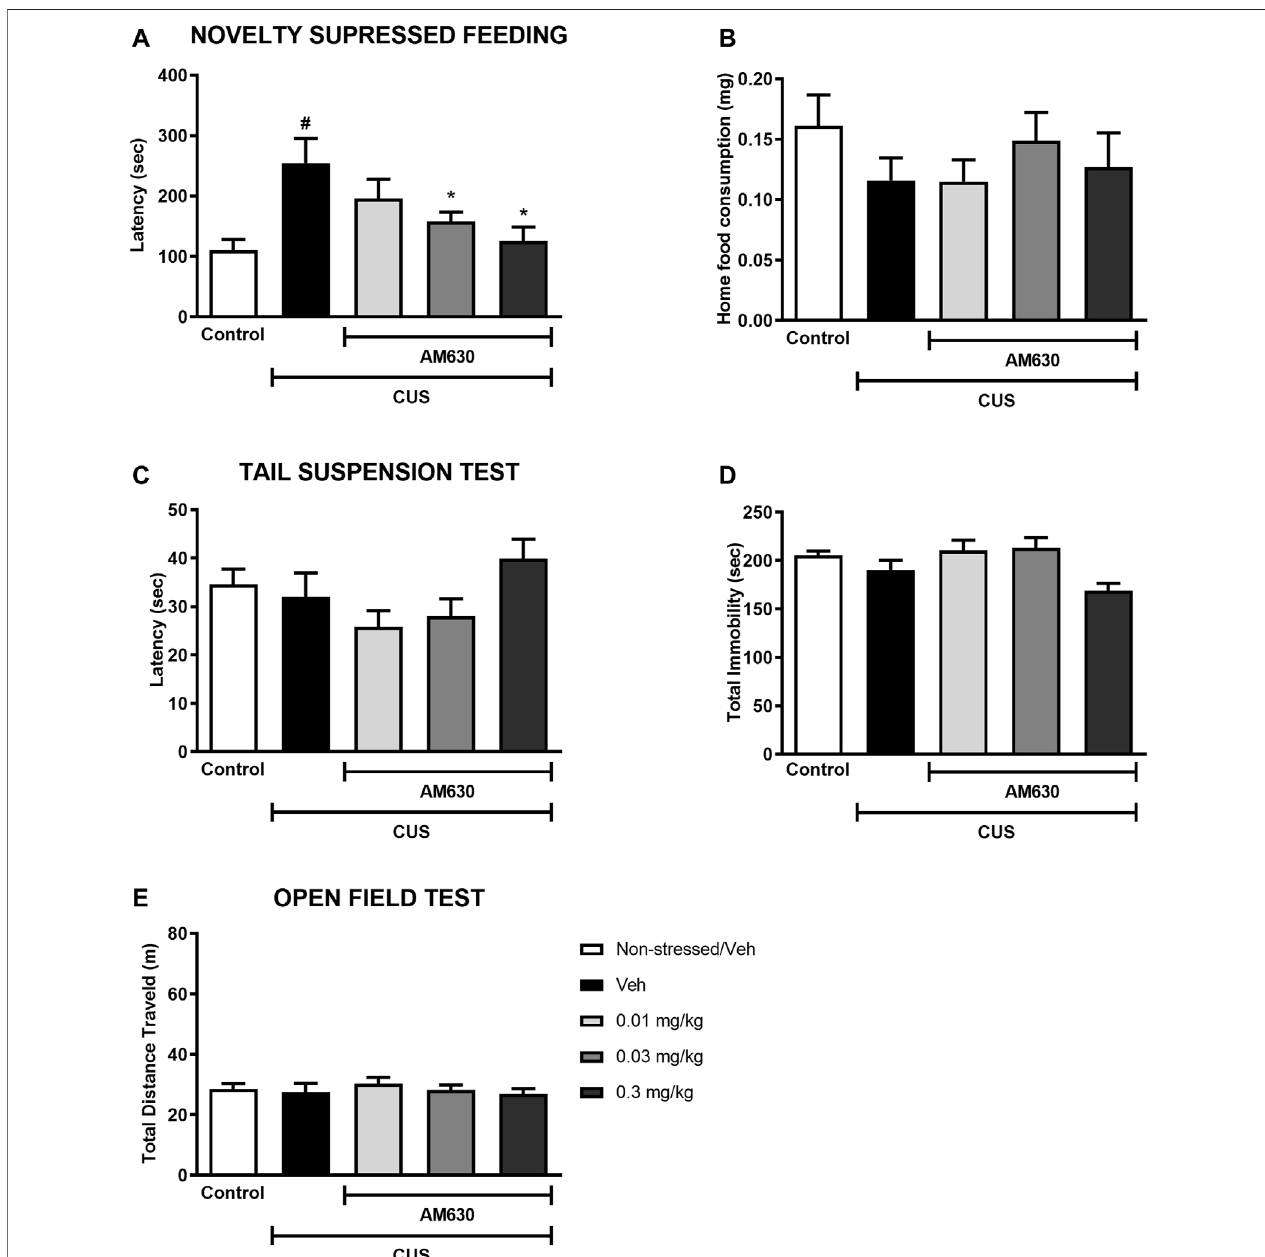
FIGURE 2 | The CB 2 receptor inverse agonist AM630 induces an anxiolytic-like effect in stressed mice after chronic treatment. Latency to feed in the NSF test in seconds (A) ,totalfoodconsumptioninthehome-cage (B) , fi rstimmobilityepisodetimeintheTSTinseconds (C) ,totalimmobilitytimeintheTSTinseconds (D) ,andthe total distance traveled, in meters (E) by animals submitted to CUS protocol and treated with Vehicle or AM630 (0.01 mg/kg; 0.03 mg/kg or 0.3 mg/kg). N (cid:1) 8/group. DatarepresentedasMean ± SEM;(#)represents p < 0.05relativetothenon-stressedcontrolgroup( t -Studenttest);(*)indicated p < 0.05relativetotheCUSgroup treated with Vehicle (One-way ANOVA followed by